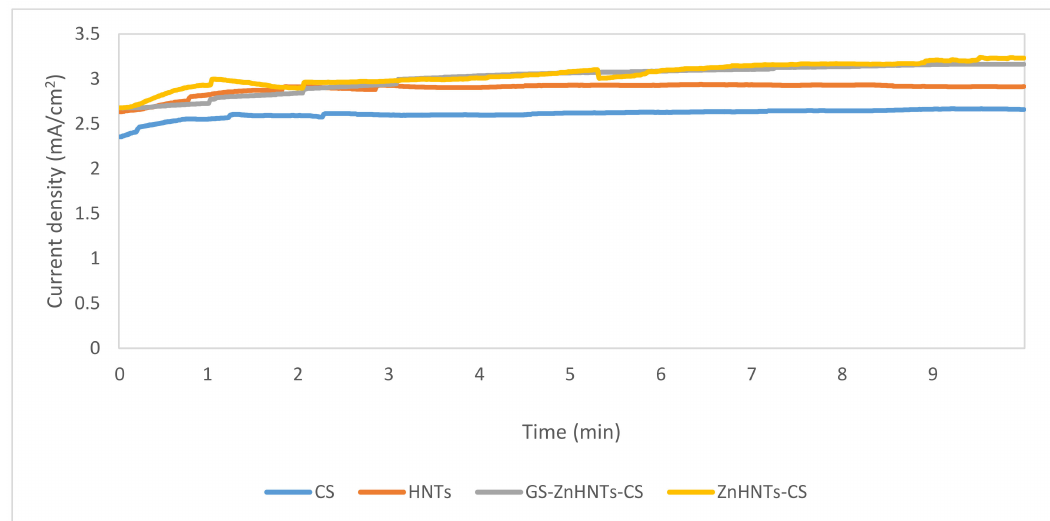
Figure 7. Current density during electrodeposition (EPD) at 40 V. The addition of ZnHNTs in the chitosan leads to increased current density, explainable based on increased conductivity due to ionic species leaching from